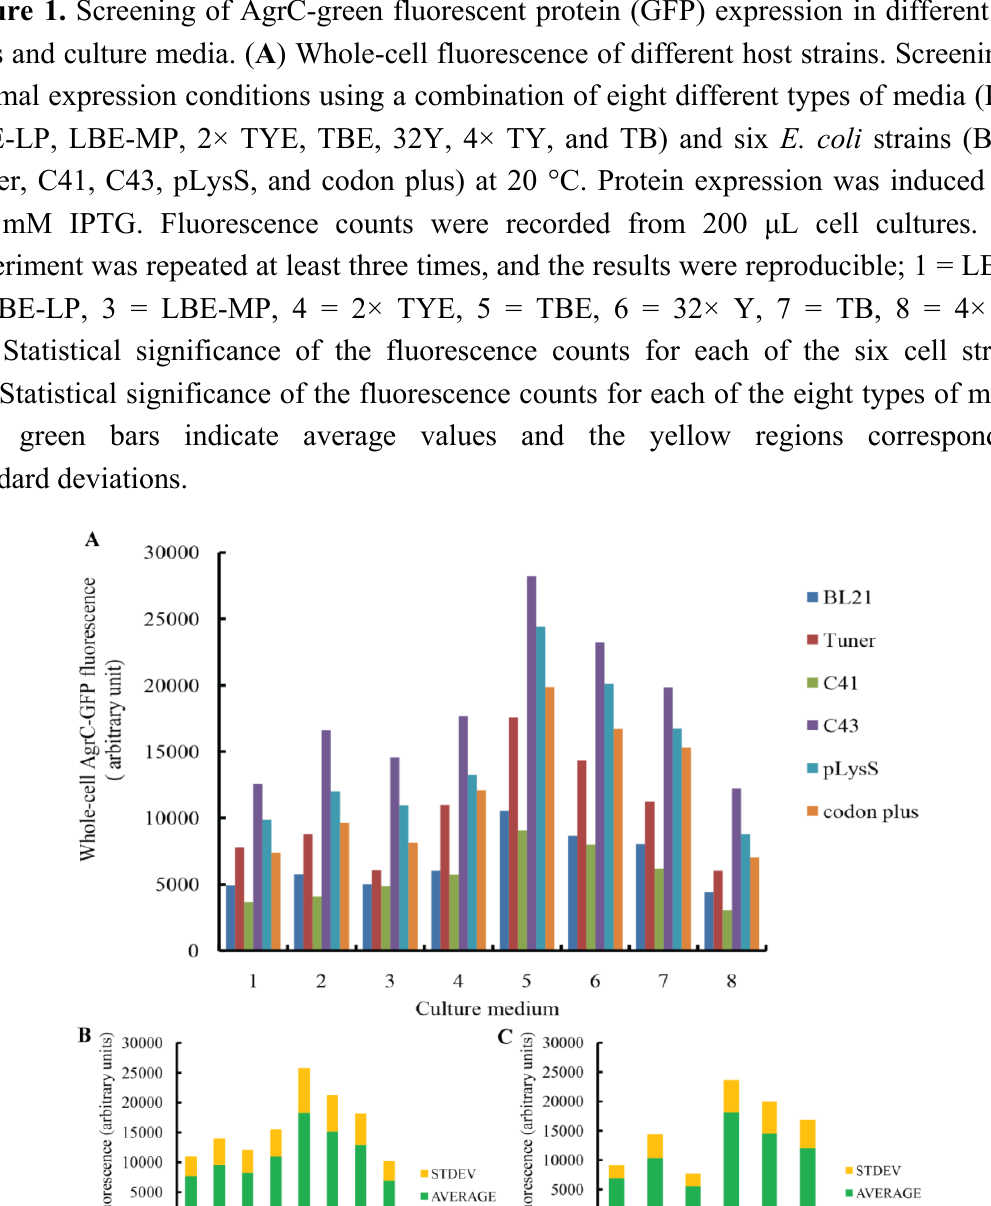
Figure 1. Screening of AgrC-green fluorescent protein (GFP) expression in different host cells and culture media. ( A ) Whole-cell fluorescence of different host strains. Screening of optimal expression conditions using a combination of eight different types of media (LBE, LBE-LP, LBE-MP, 2× TYE, TBE, 32Y, 4× TY, and TB) and six E. coli strains (BL21, Tuner, C41, C43, pLysS, and codon plus) at 20  C. Protein expression was induced with 0.1 mM IPTG. Fluorescence counts were recorded from 200 μ L cell cultures. This experiment was repeated at least three times, and the results were reproducible; 1 = LBE, 2